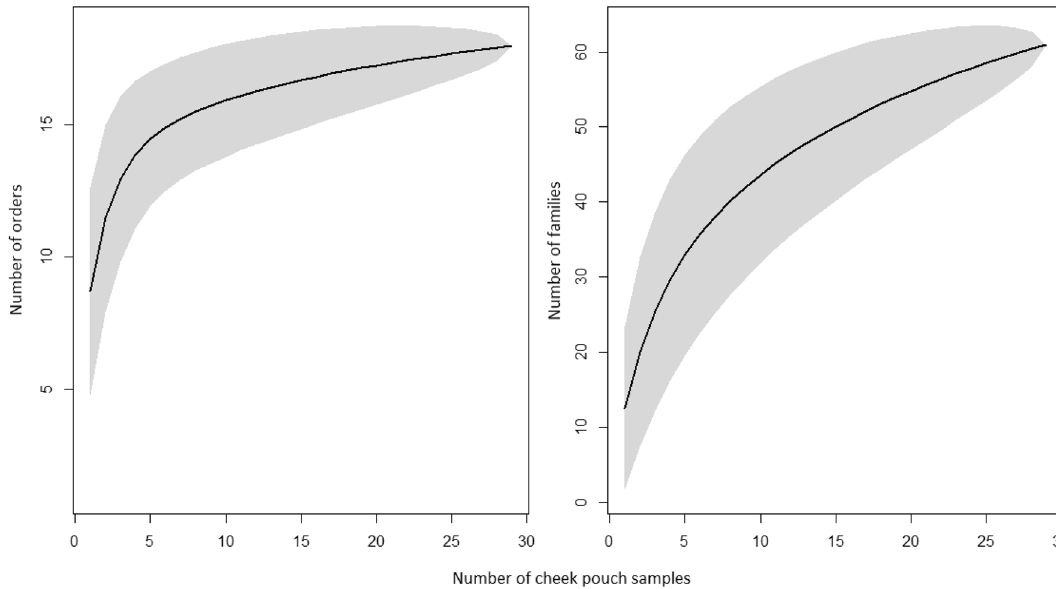
Figure 2. Accumulation curves for ( a ) orders and ( b ) families detected in platypus cheek pouch